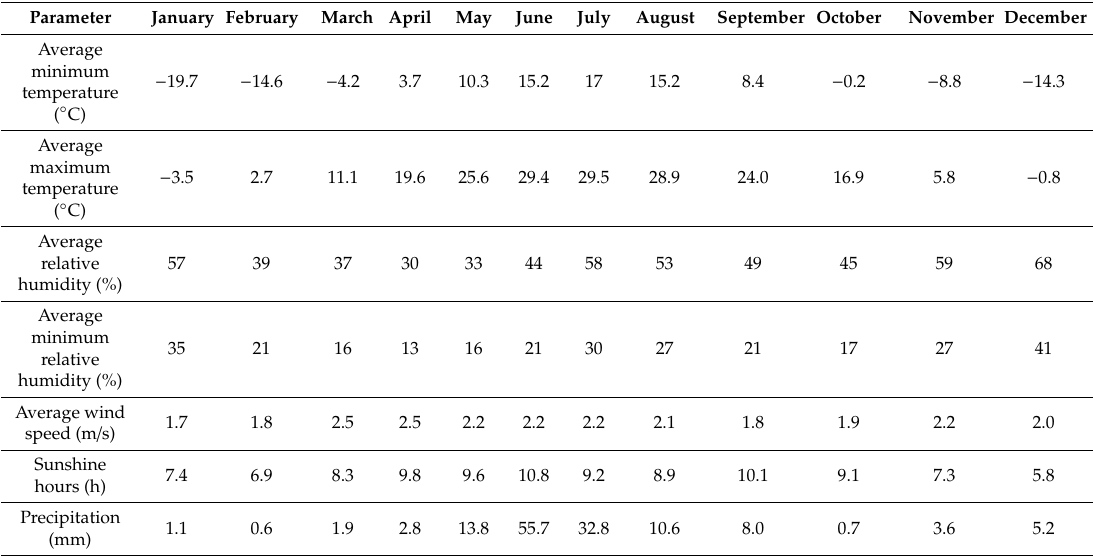
Table 1. Monthly average of meteorological parameters of Zhangye Site in